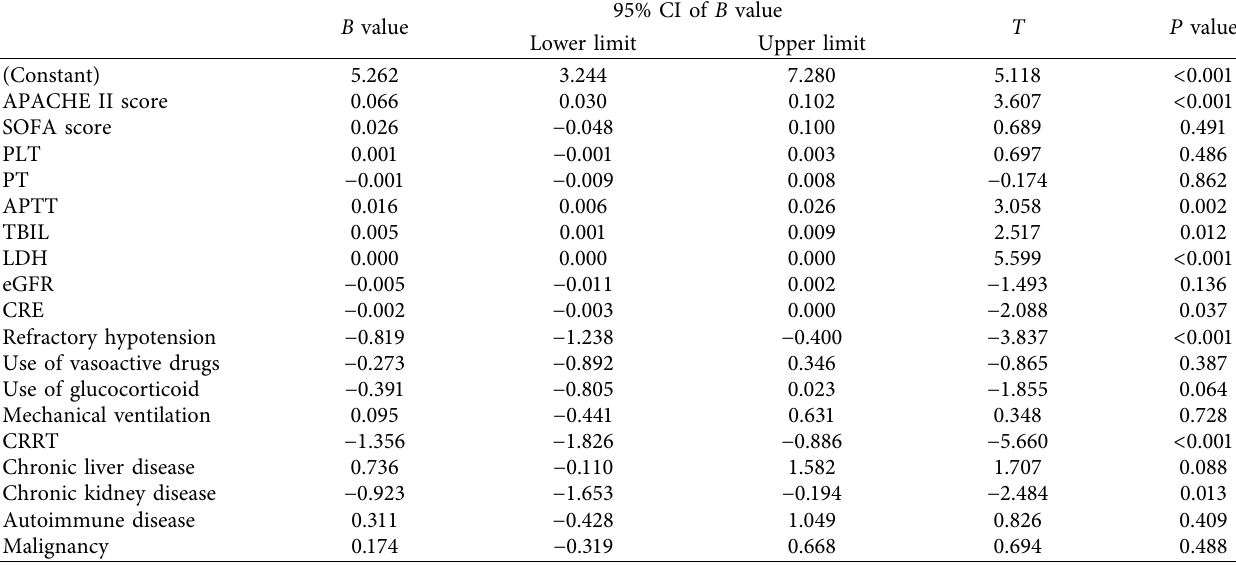
Table 3: Multivariate analysis of predictive factors for lactate level in sepsis patients.